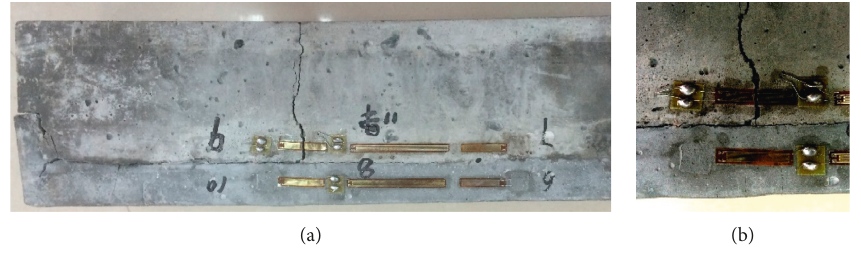
Figure 11: Cracking pattern of the unbonded composite